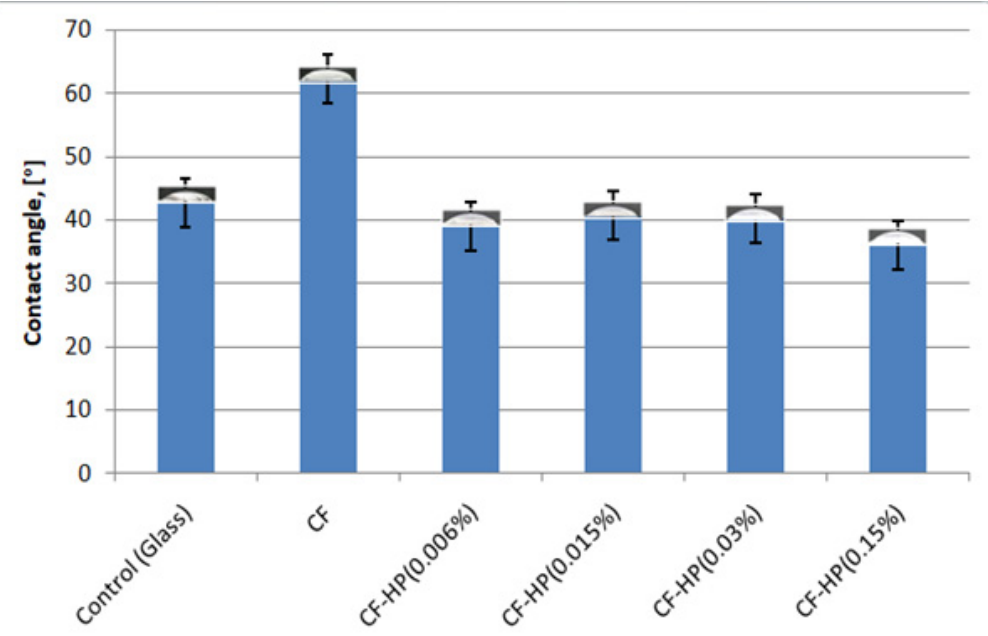
Figure 2. Contact angles of the collagen fibrils after different HP treatment: CF—collagen fibrils before treatment; CF-HP (0.006%)—collagen fibrils after HP treatment with concentration 0.006%; CF-HP (0.015%)—collagen fibrils after HP treatment with concentration 0.015%; CF-HP (0.03%)—collagen fibrils after HP treatment with concentration 0.03%; CF-HP (0.15%)—collagen fibrils after HP treatment with concentration 0.15%.